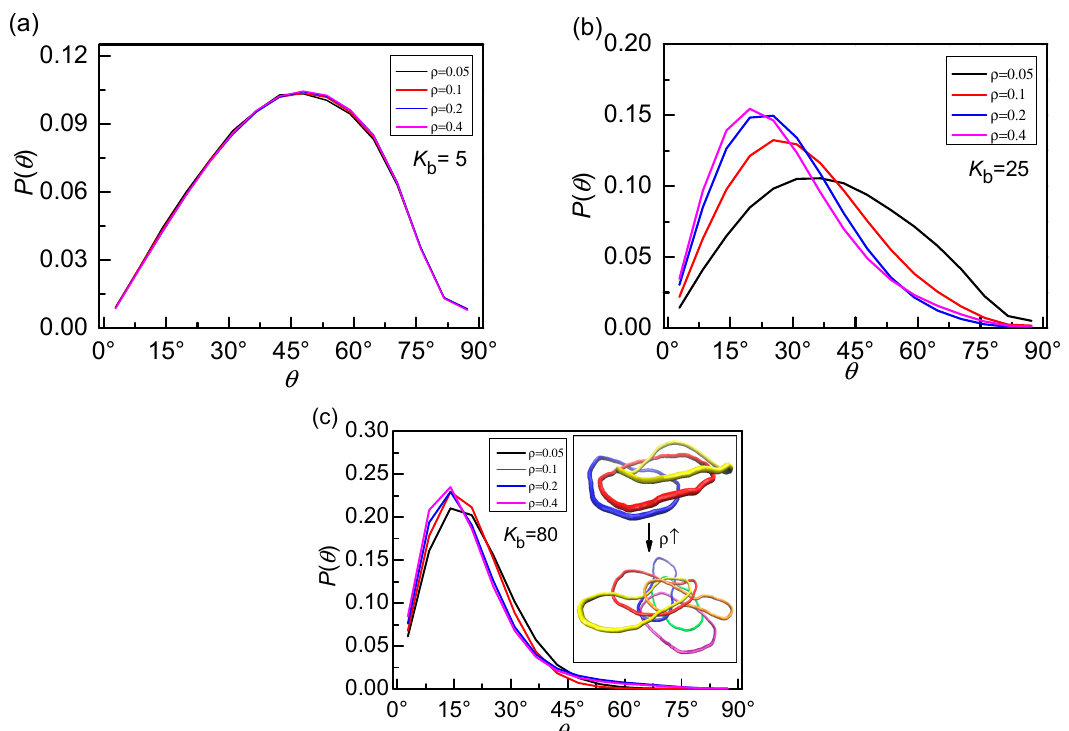
different number densities ρ . P th increases with the increase of the number density.